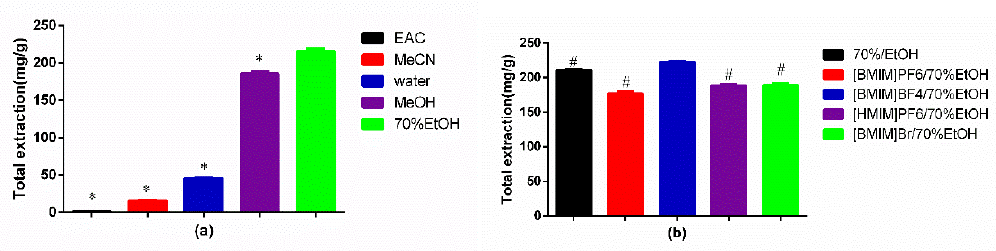
Figure 4. ( a ) Effects of five conventional extraction agents on extraction yields of target analytes; ( b ) effects of four kinds of ILs with 70%EtOH on extraction yields of target analytes. * p < 0.05, compared with 70%EtOH group; # p < 0.05, compared with [BMIM]BF 4 /70%EtOH group.